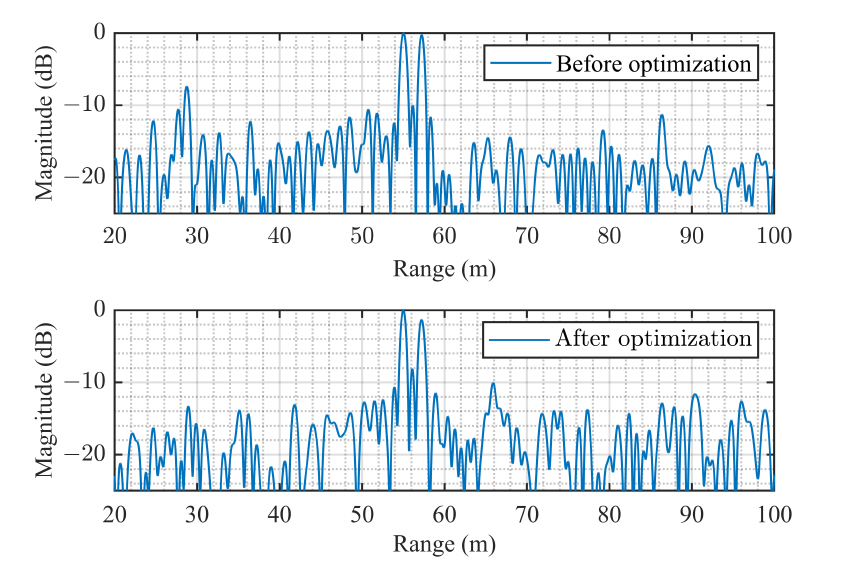
Figure 10. Range